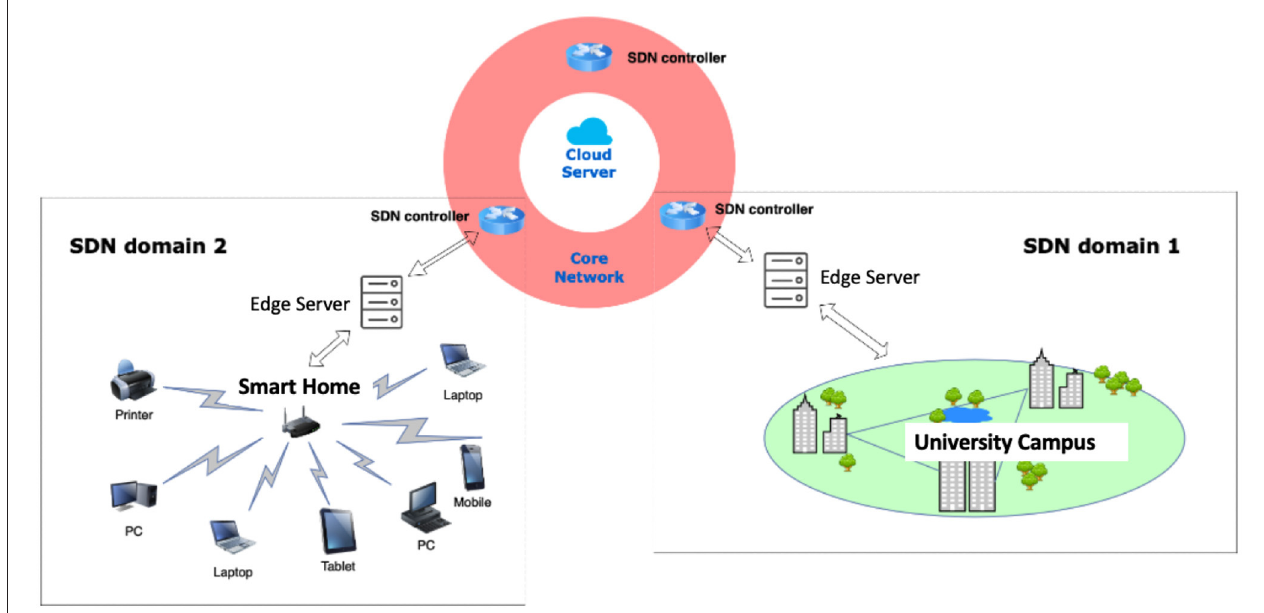
FIGURE 2 | An example of SDN solution of IoT